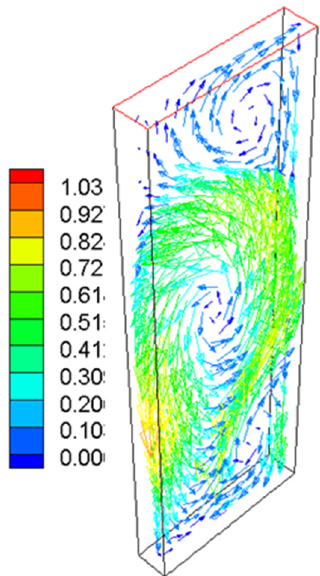
Figure 7. Contour of the velocity vector of the central surface in the column.